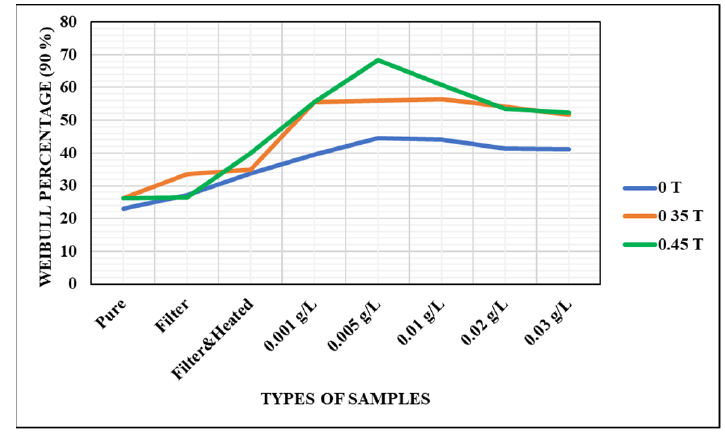
Figure 7. Weibull percentage of 90 % of breakdown voltage.